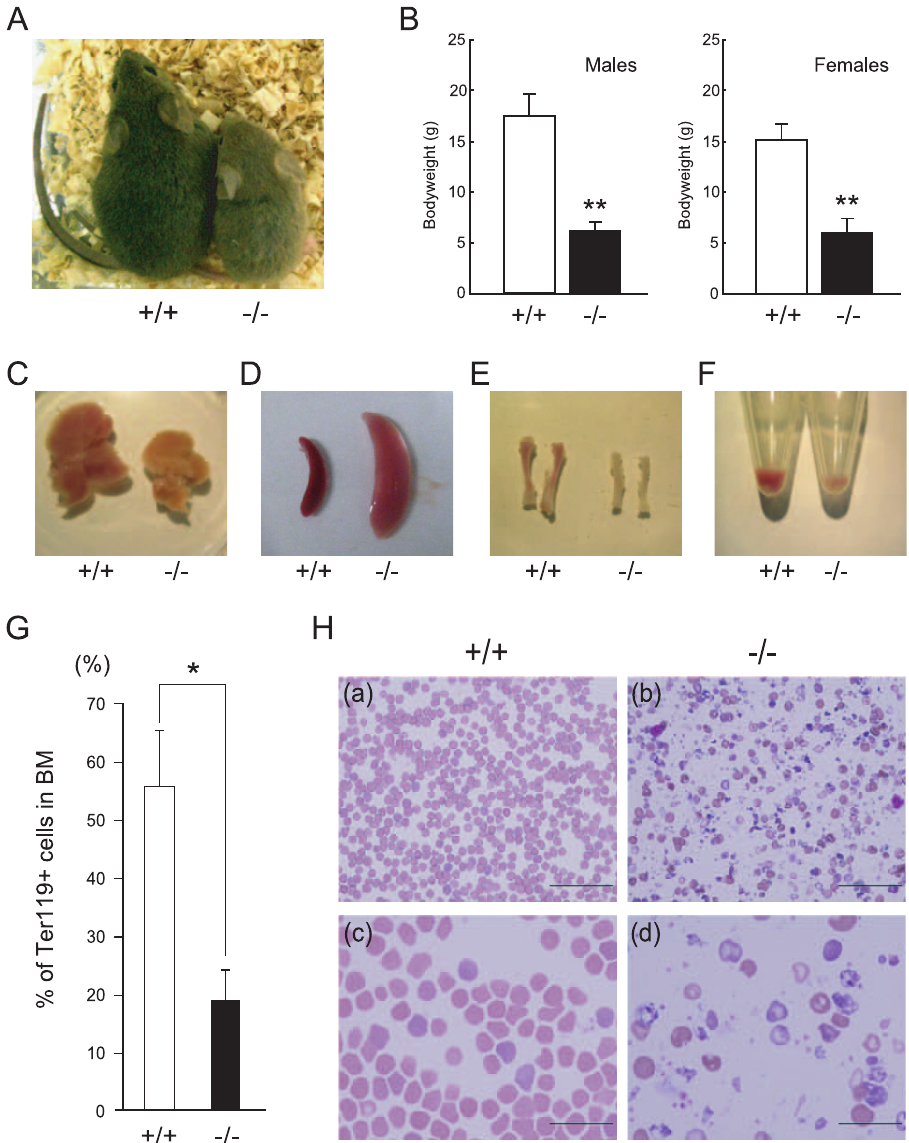
Figure 2. Growth retardation and peripheral blood morphology in postnatal CALM -deficient mice. (A) Wild-type ( + / + ) (left) and CALM - deficient ( 2 / 2 ) (right) mice at 3 weeks of age. (B) Average weight of wild-type ( + / + ) and CALM -deficient ( 2 / 2 ) mice at postnatal day 28. Data shown represent CALM -deficient males (n=3), CALM -deficient females (n=4), wild-type males (n=36), and wild-type females (n=35). **, P , 0.01 vs control. Liver (C), spleen (D) and tibia (E) from wild-type ( + / + ) or CALM -deficient ( 2 / 2 ) mice at 3 weeks of age. (F) Bone marrow cells were collected by centrifugation. Note that the pellet from CALM -deficient ( 2 / 2 ) mice is small and pale in color. (G) Quantification of TER119-positive bone marrow cells (data represent means 6 SD; n=5). *, P , 0.05 vs. control. (H) Peripheral blood smears from wild-type ( + / + ) littermates (left panels, a and c) or CALM -deficient ( 2 / 2 ) mice (right panels, b and d) at 3 weeks of age. Magnification: upper panels, 400 6 ; lower panels, 1000 6 . Scale bar, 50 m m (upper panel) and 20 m m (lower